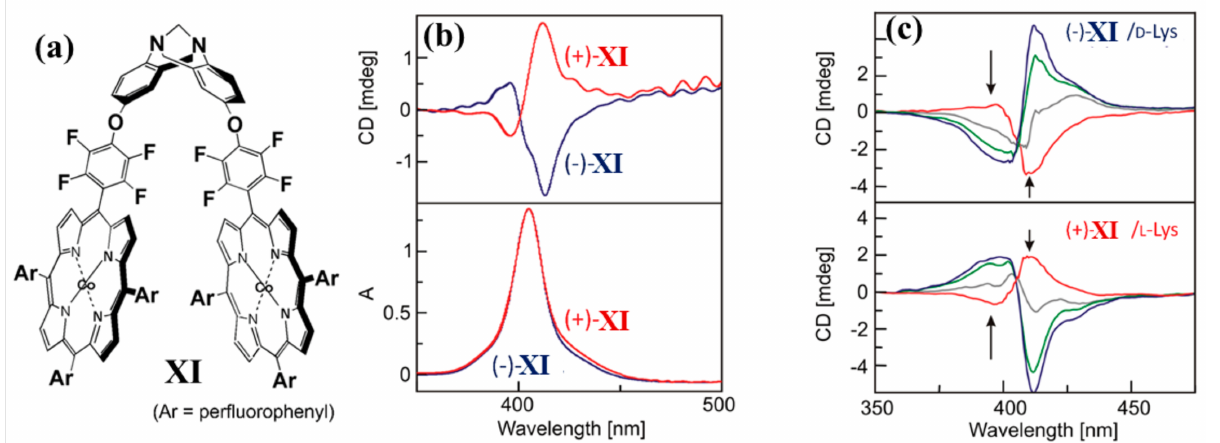
Figure 8. ( a ) Structure of cobalt-bis-porphyrin derivate XI ; ( b ) CD (top) and UV/Vis (bottom) spectra of the enantiomers of XI in dichloromethane; ( c ) Titration CD spectra of XI stereoisomers with an increasing amount of D- and L-lysine methyl ester. Adapted with permission from reference [66]; published by John Wiley and Sons